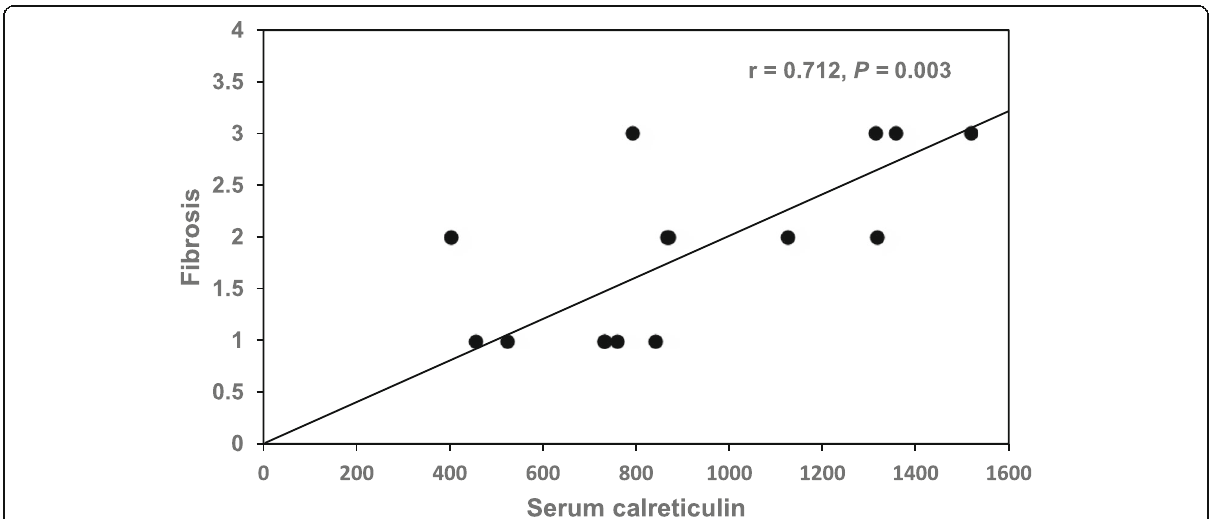
Fig. 3 Correlation between serum calreticulin (S. CRT) level (ng/dl) with the degree of renal fibrosis in renal transplant recipients with chronic allograft dysfunction